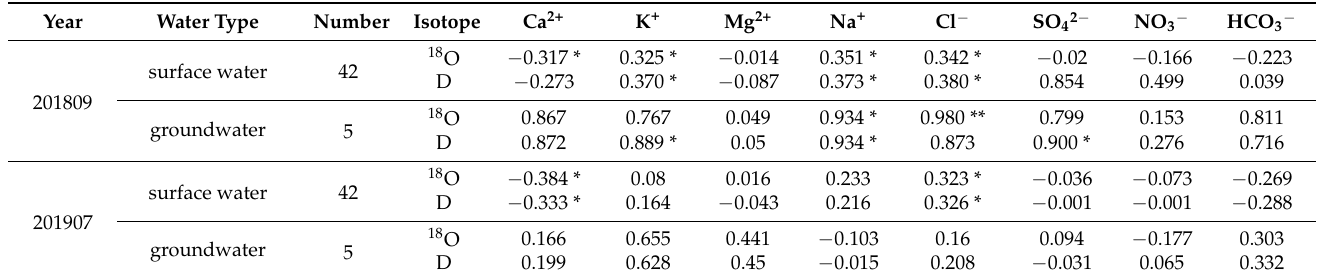
Table 1. Correlation analysis of hydrochemical and hydrogen and oxygen isotopic composition in the mountainous watershed of Daqing